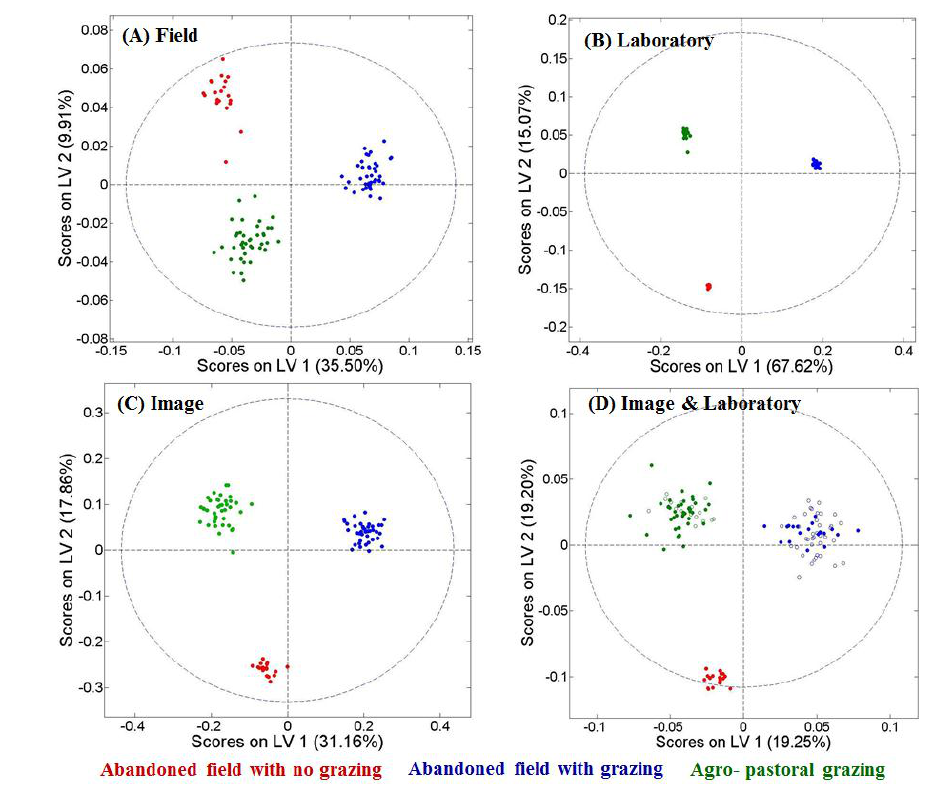
Figure 9. Partial least squares-discriminant analysis (PLS-DA) classification of the different land uses in the Migda site, Israel, using data of: ( A ) field spectroscopy; ( B ) laboratory spectroscopy; ( C ) airborne imaging spectroscopy; and ( D ) merged image and laboratory spectroscopy. Dashed circles indicate the 95% confidence